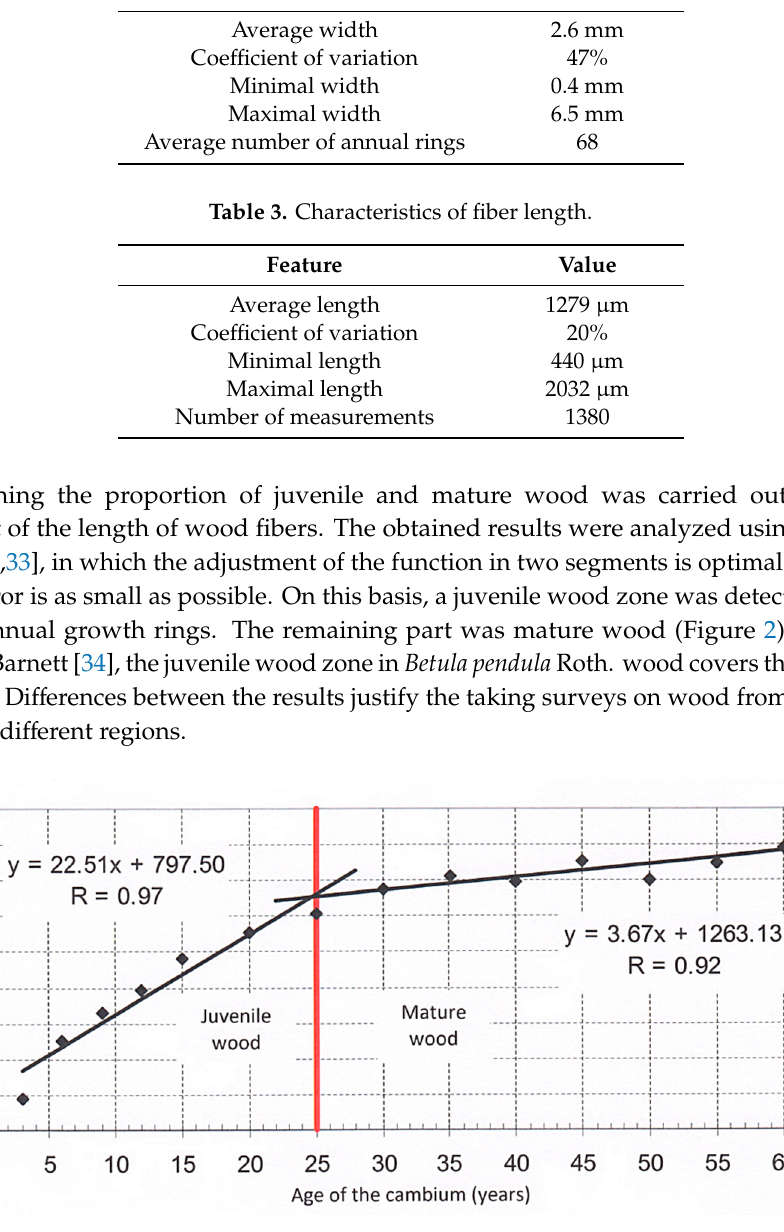
Figure 2. Juvenile and mature wood in the examined birch wood.